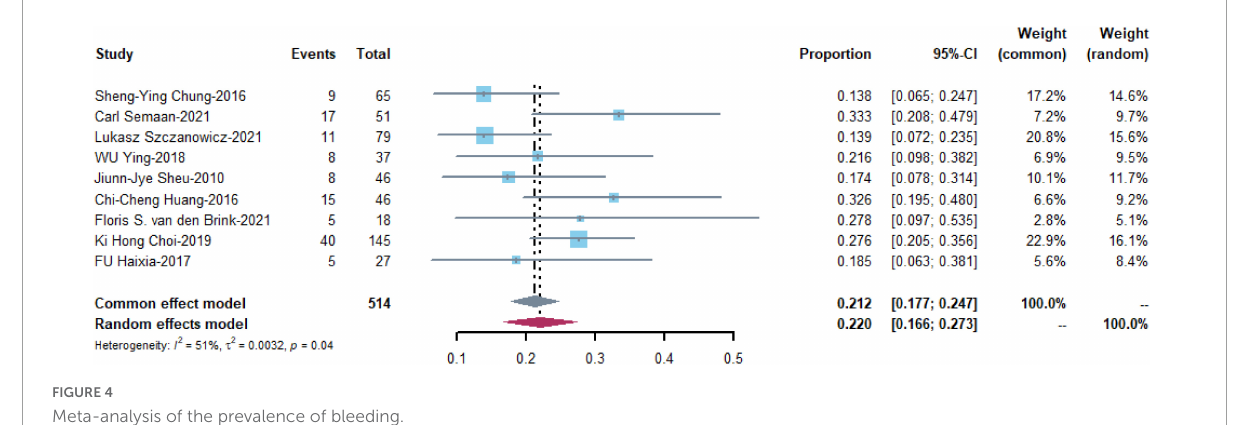
FIGURE4 Meta-analysis of the prevalence of bleeding.